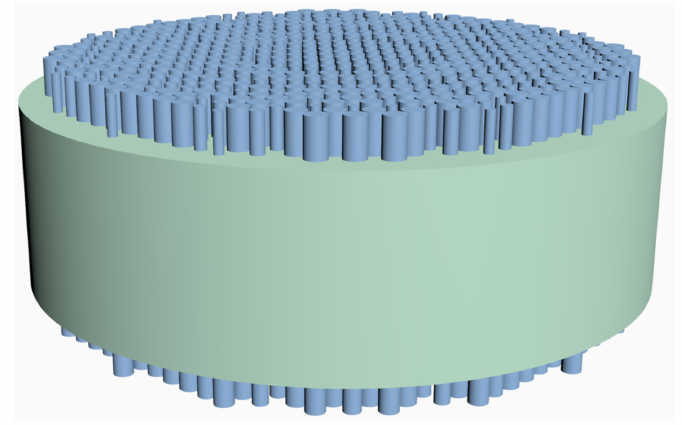
Figure 6. Schematic of three-dimensional structure of the doublet metalens, composed of a silicon aperture metalens and a silicon focusing metalens separated by a fused silica substrate.